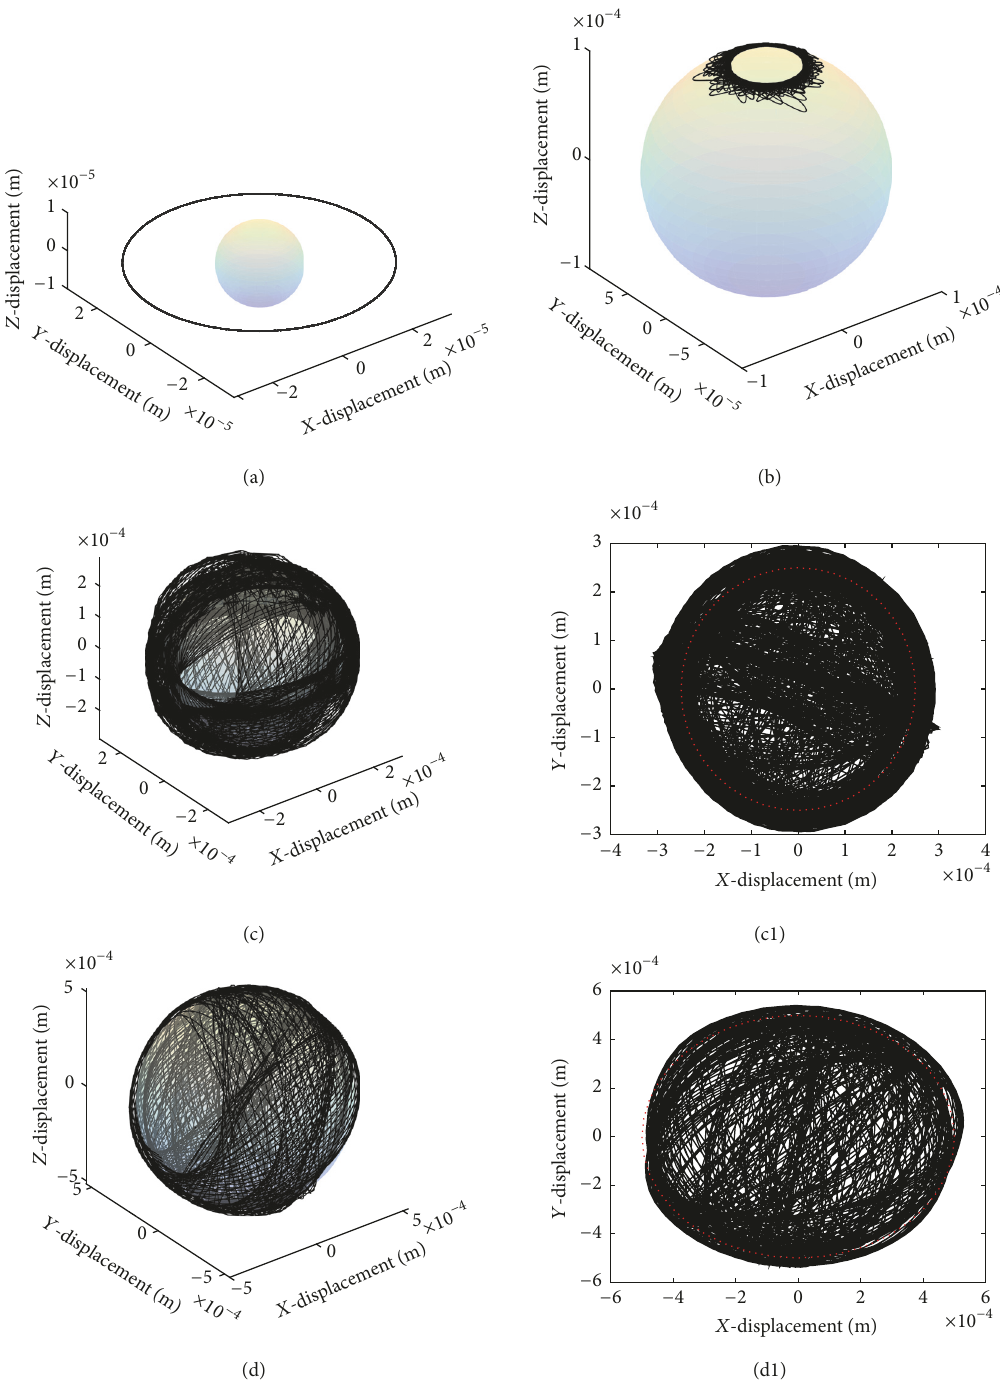
Figure 19: Trajectory of the ball center of different clearances: (a) 𝑐 = 0.01 mm; (b) 𝑐 = 0.1 mm; (c) 𝑐 = 0.25 mm; (c1) a sectional view of Figure (c); (d) 𝑐 = 0.5 mm; (d1) a sectional view of Figure